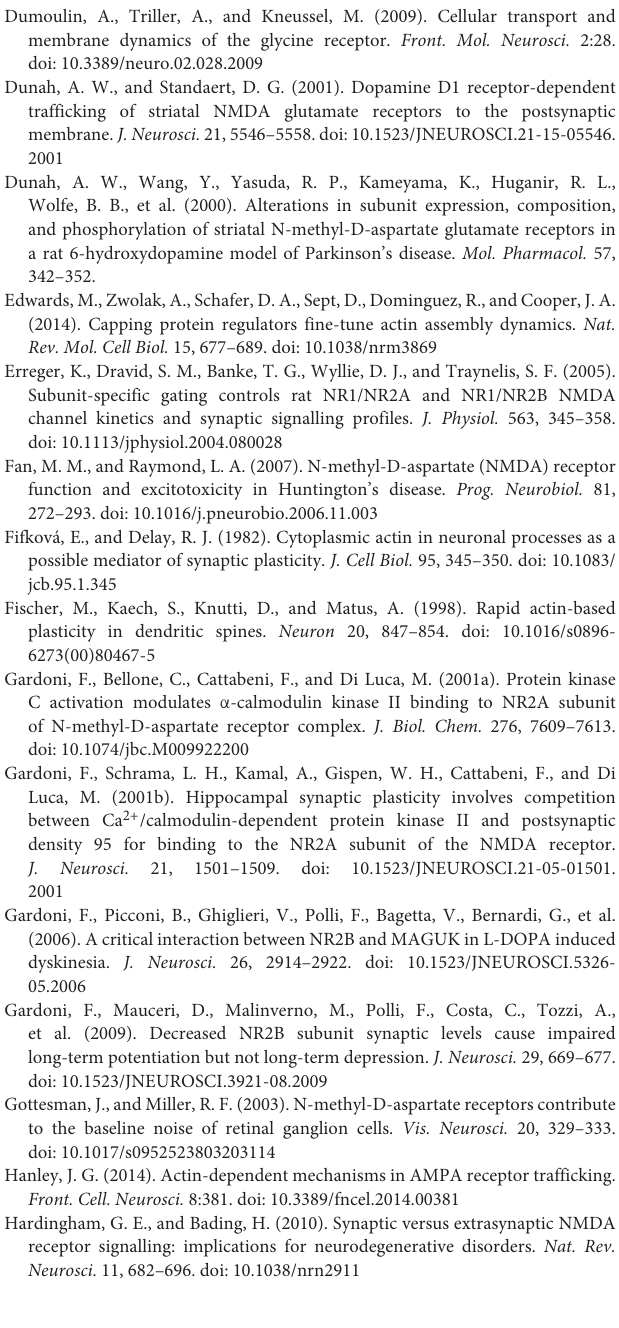
FIGURE S1 | (A) Examples of whole-cell patch clamp recordings of mEPSCs from WT and KO hippocampal neurons treated or not with TTX (1 µ M) for 48 h to induce homeostatic plasticity. (B) Quantitation of mEPSC amplitude in control and TTX conditions showing that both WT and KO neurons were able to undergo homeostatic potentiation (WT ctrl, pA: 22.25 ± 0.7 n = 8 cells, WT TTX: